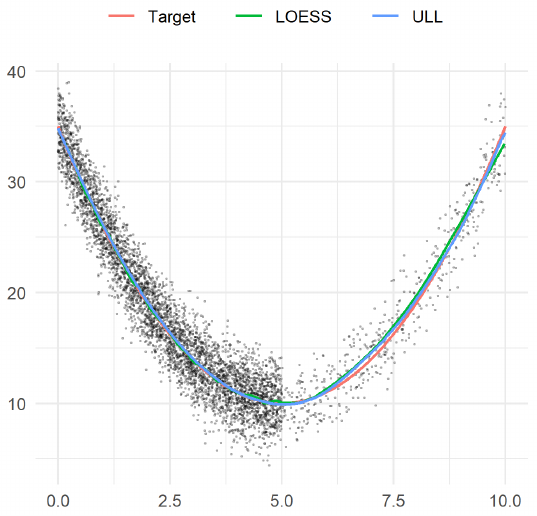
Figure 1. Example 2. Sample observations, target function, and two